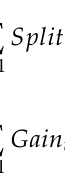
Figure 3. Building process of rockburst characteristic variables prediction model.